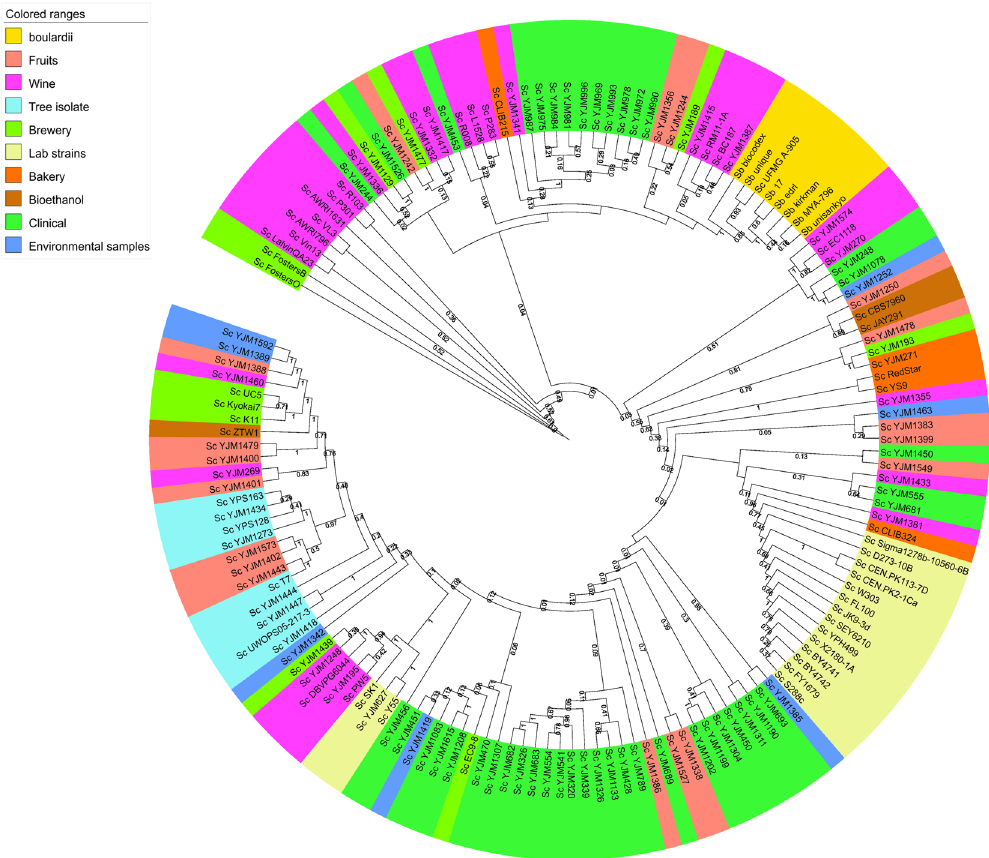
Figure 4. Maximum Evolution tree for 182 orthologous proteins of all strains of Sb , Sc and S. kudriavzevii as outgroup species. The taxa are shaded based on the isolation source of strains as boulardii: gold; Fruits: lightsalmon; Wine: hotpink; Tree isolate: skyblue; Brewery: lawngreen; Lab strains: palegoldenrod; Bakery: darkorange; Bioethanol: peru; Clinical: mediumseagreen; Environmental samples: